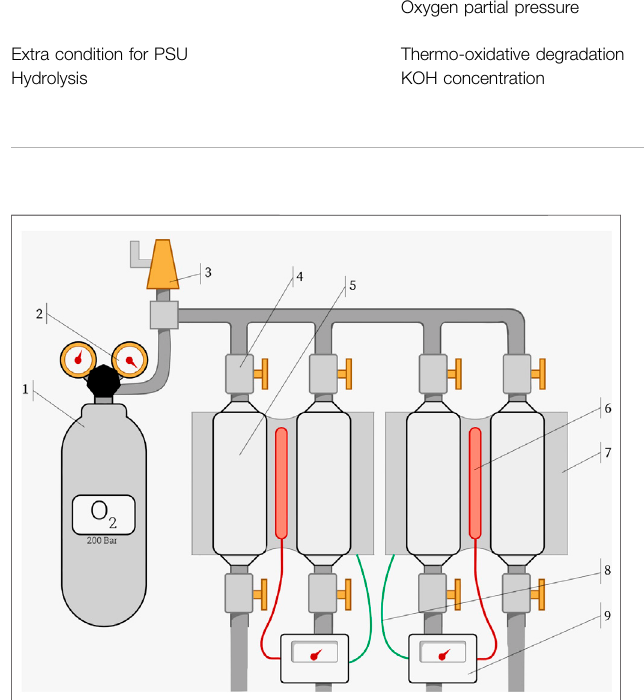
FIGURE 3 | Schematic of the oxygen set-up containing the following parts: 1)5L200 barpure oxygen fl ask, 2)pressureregulator,3) pressurerelief valve set at 8 bar, 4) oxygen certi fi ed Swagelok needle valve, 5) 18 mm Swagelok tube containing the samples, 6) heating element, 7) aluminum block for heating the tubes, 8) thermocouple, and 9) SB1 PID temperature regulator from RKC INSTRUMENT Inc. Heating paste has been applied between the heating element and aluminum block and between the 18 mm tubes and the aluminum block.